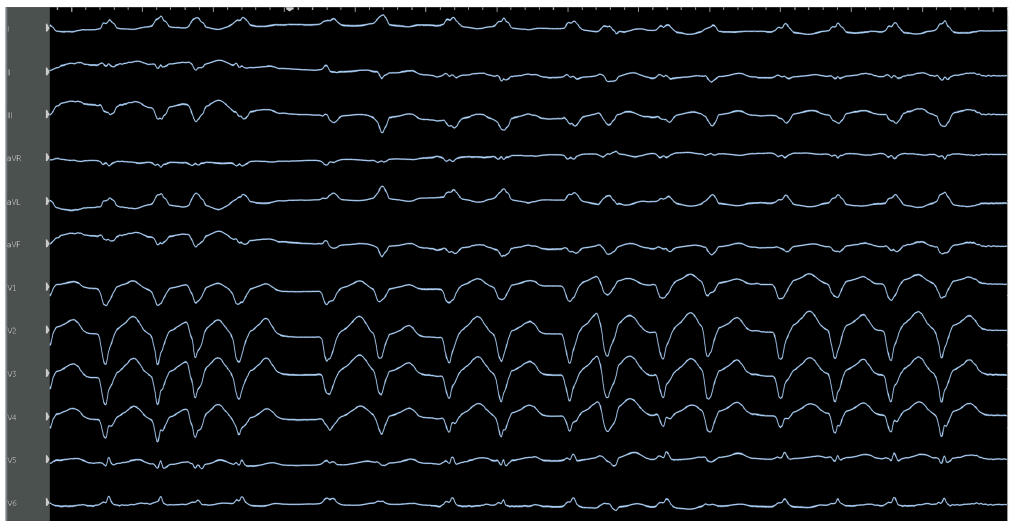
Figure 15. Characteristic ECG of moderator band VT-showing LBBB, left superior axis with S wave more negative in III than II, transition occurs late at V5 (given the apical exit) and variable QRS morphology is seen. Successful ablation was performed on the moderator band towards the insertion onto the papillary muscle close to the free wall.